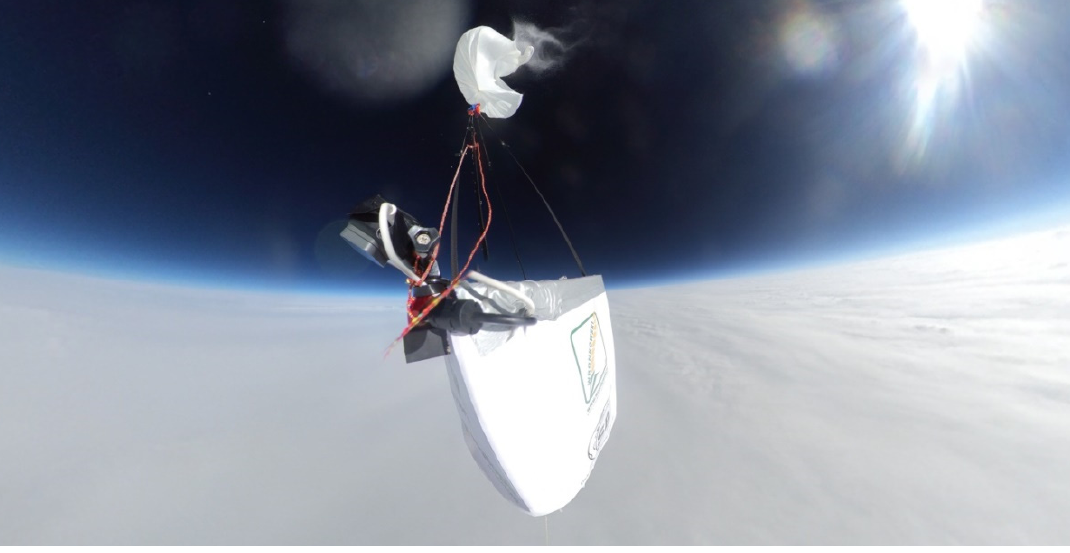
Figure 21. The view from the 360° camera affixed on the main gondola’s lid at the moment of the balloon burst at the maximum reached altitude. Below the gondola, the upper surface of the encountered storm front can be seen. The visibility inside the storm front dropped to single meters.